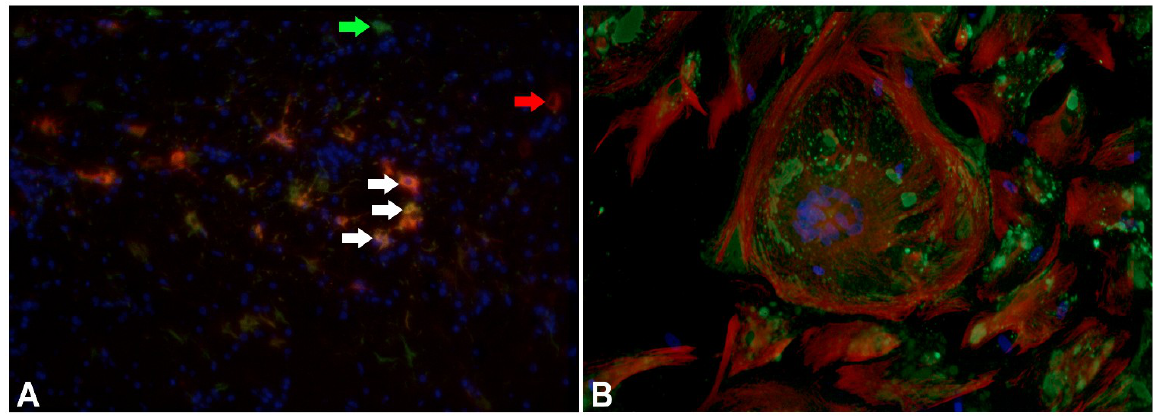
Figure 3. Immature astrocytes are characterized by expression of vimentin in CDV-DL. ( A ) Detection of glial fibrillary acidic protein (GFAP; green; Cy2-labeled secondary antibody; green arrows) and vimentin (red; Cy3-labeled secondary antibody; red arrow) expression in a chronic distemper lesion. Co-localization of GFAP and vimentin is displayed by a yellowish color in the cytoplasm of astrocytes (white arrows). Counterstaining of nuclei with bisbenzimide (blue). 200 fold magnification; ( B ) Immunostaining for vimentin and CDV antigen in adult canine mixed primary cell cultures infected with CDV strain R252 at 30 days post infection. Vimentin expression in mono- and multinucleated cells characterized by a fine fibrillary network (red: vimentin, Cy3-labeled secondary antibody). CDV antigen is mainly found in the cytoplasm (green: CDV nucleoprotein, Cy2-labeled secondary antibody). 400 fold